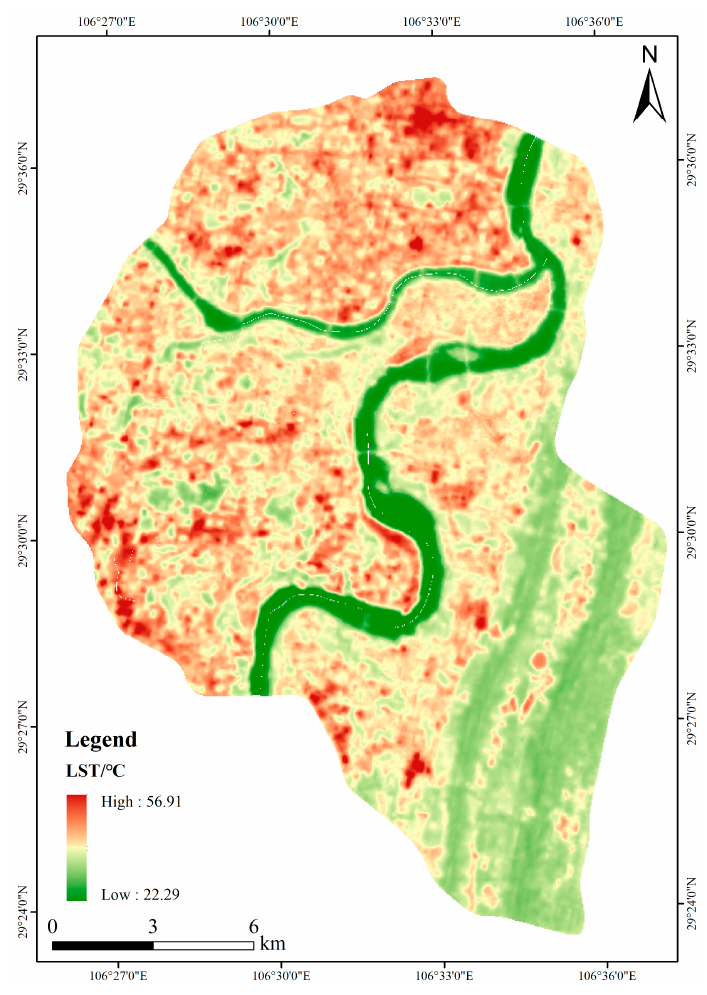
Figure 4. LST result based on the atmospheric correction method.